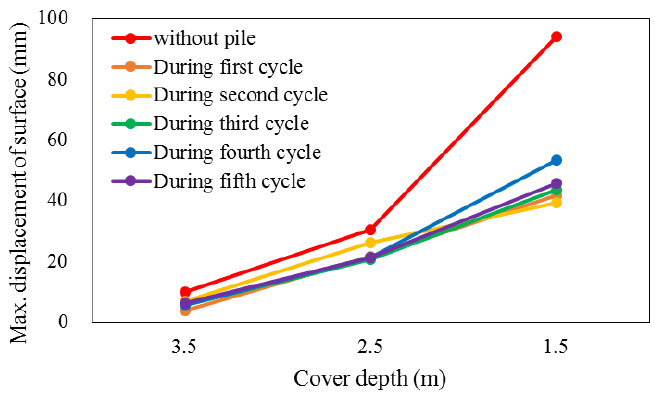
Figure 22. Displacement during Stage 2 of each construction cycle based on cover depth.